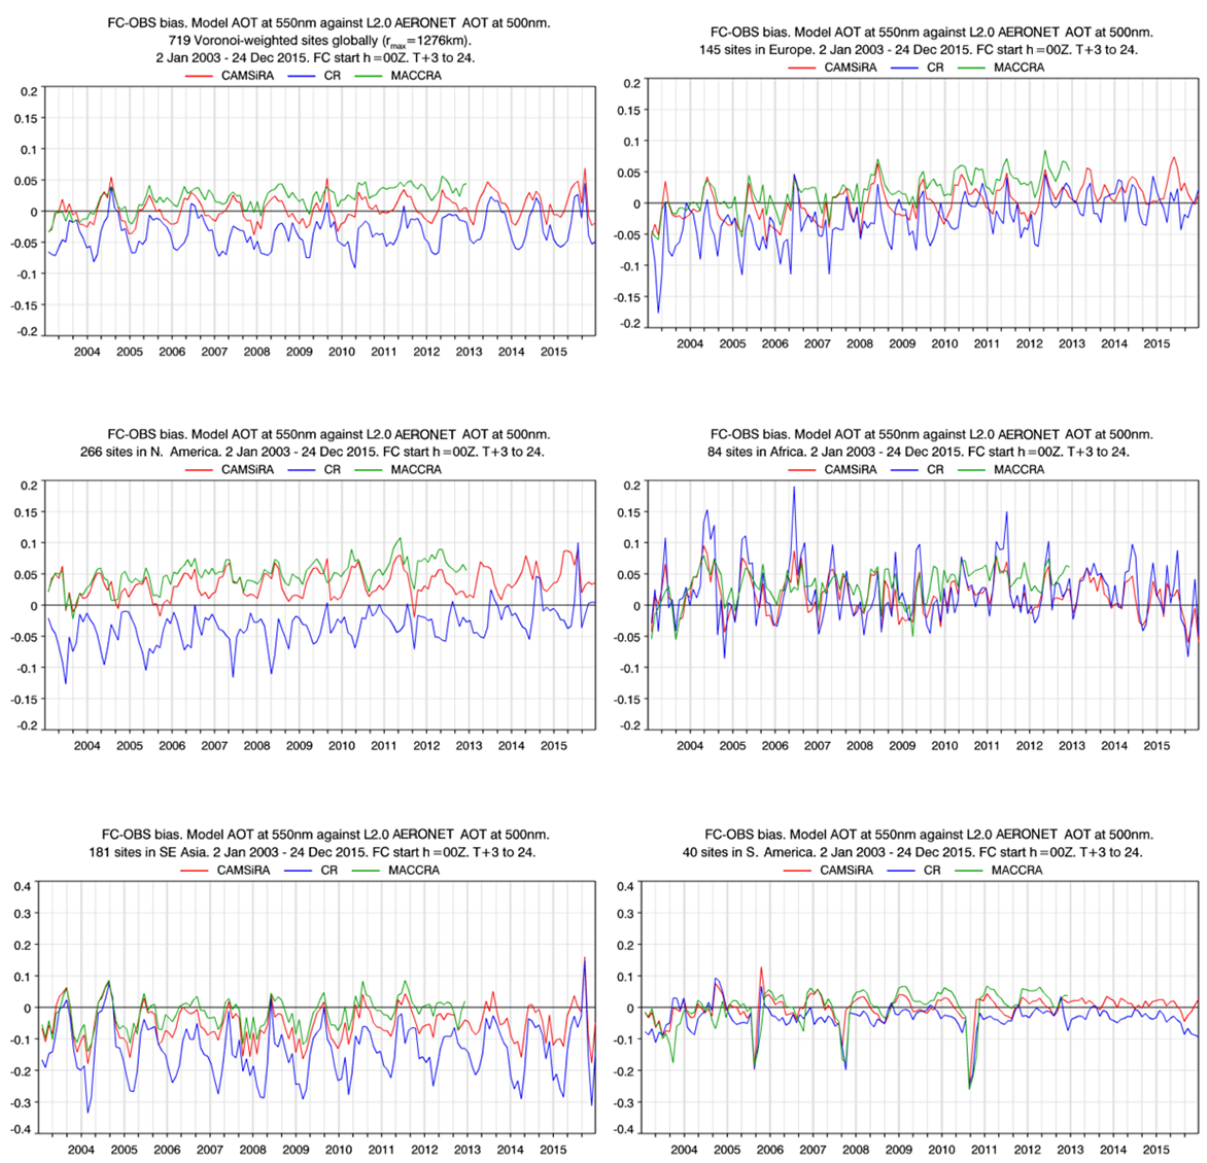
Figure 11. Time series of monthly mean bias of AERONET AOD observations averaged over the whole globe (top left), Europe (top right), North America (middle left), Africa (middle right), South East Asia (bottom left), and South America (bottom right) for CAMSiRA (red), the CR (blue), and MACCRA